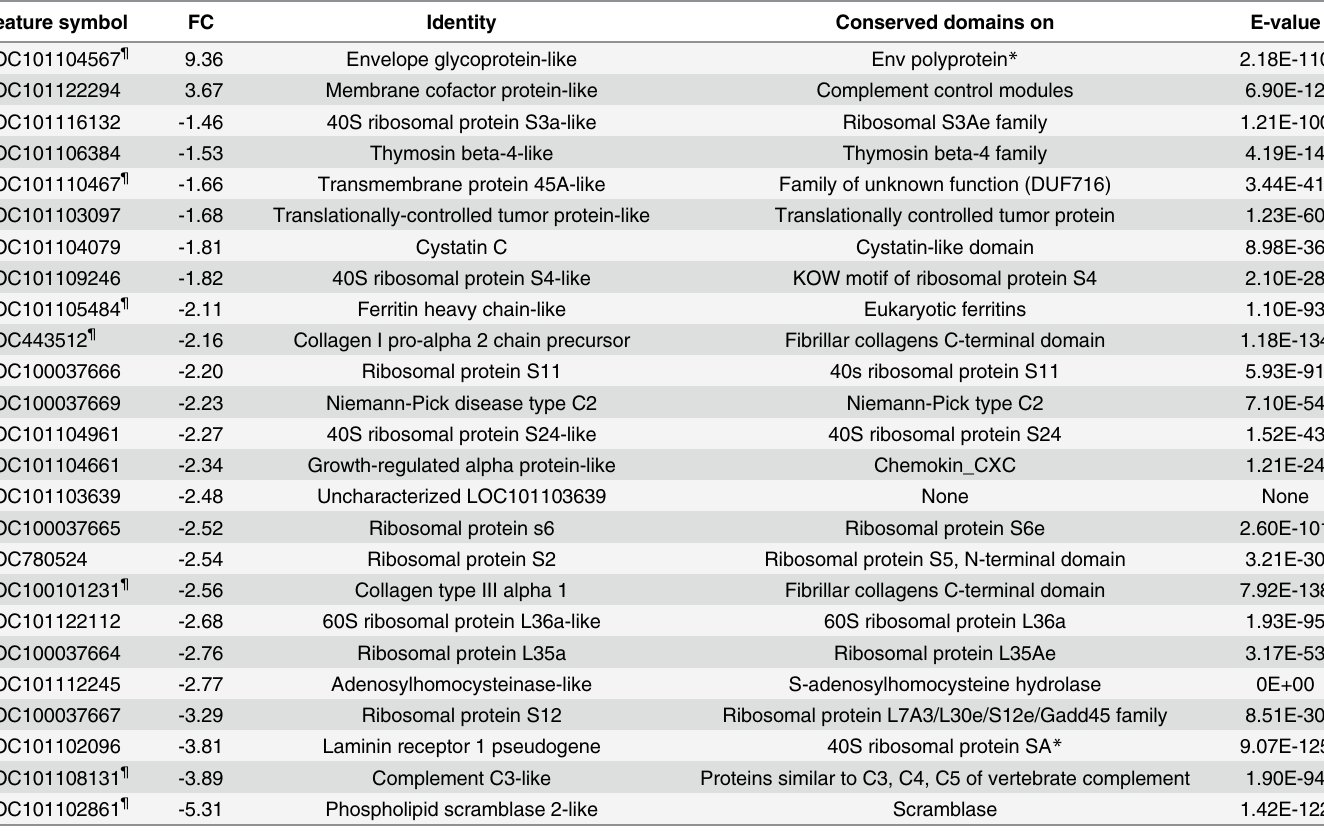
Table 3. Genes encoding for hypothetical proteins with altered transcription in mock-inoculated microglia clones. Feature symbol